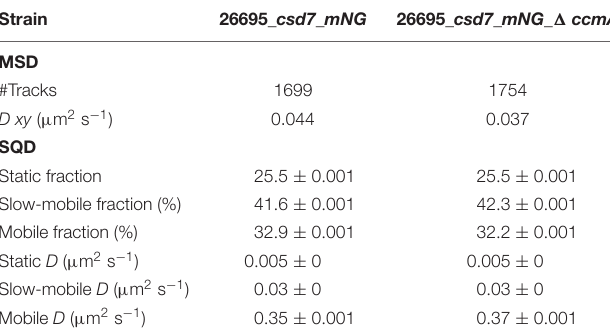
TABLE 5 | Summary of Csd7_mNG single-molecule dynamics in H. pylori 26695. Strain 26695